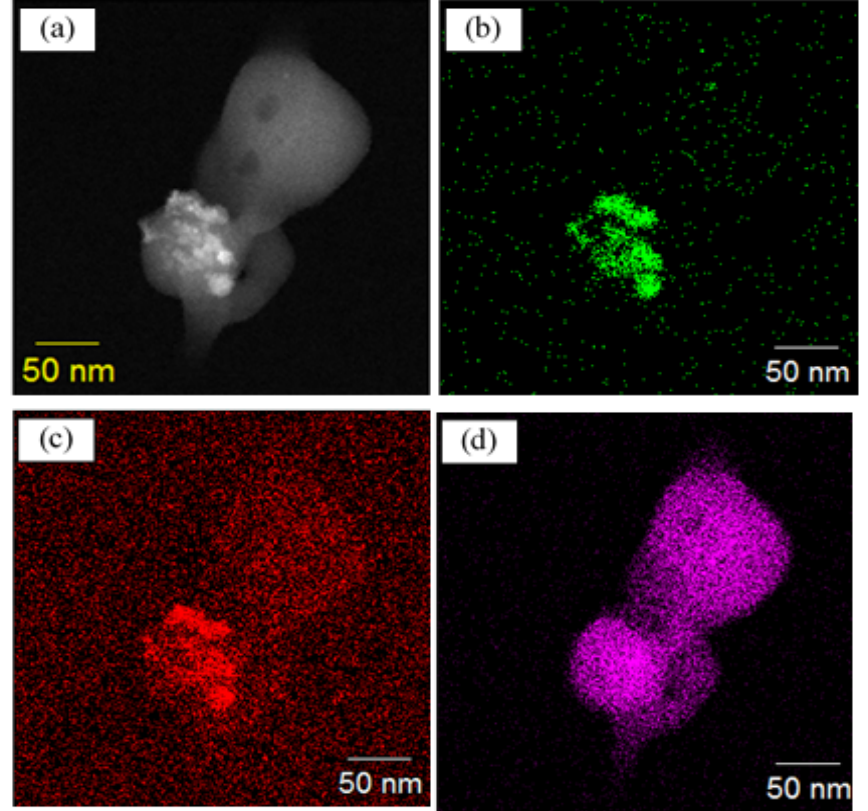
Figure 12. STEM image of titanium dioxide nanoparticles ( a ) with the corresponding EDS maps for titanium ( b ), oxygen ( c ), and carbon ( d ) elements [43]. titanium ( b ), oxygen ( c ), and carbon ( d ) elements